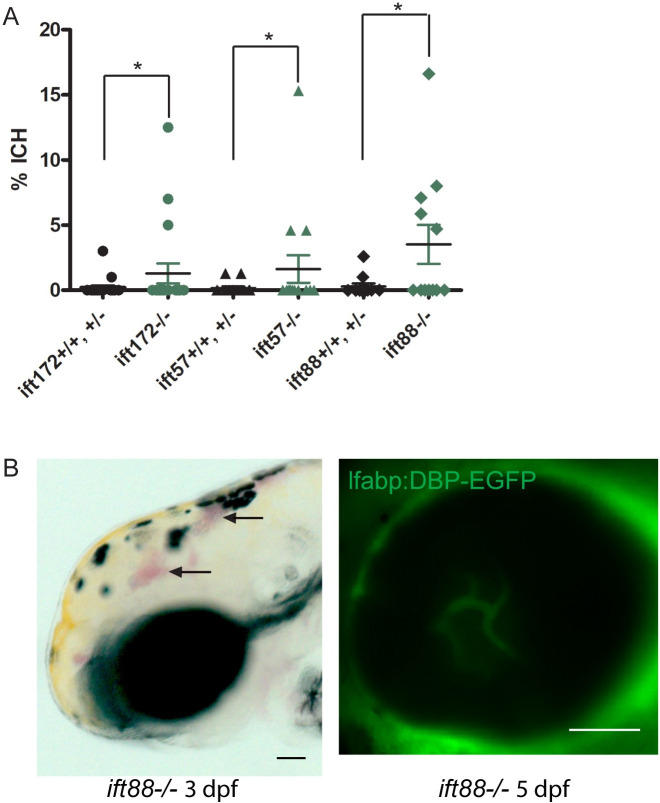
Ift mutant fish with ICH maintain an intact BRB.Embryos were screened daily for ICH and BRB integrity was assessed at 5 dpf. (A) Average percentages of ift172-/-, ift57-/-, and ift88-/- embryos and their wild type and heterozygous siblings with ICH (n = 18 ift172 crosses, 15 ift57 crosses, and 10 ift88 crosses of ≥ 50 embryos each). Error bars = SEM. *P < 0.05 by Fisher’s exact test. (B) An ift88-/- embryo with ICH at 3 dpf (bright field image at left, arrowheads) and an intact BRB at 5 dpf (confocal micrograph at right). Scale bar = 50 μm.